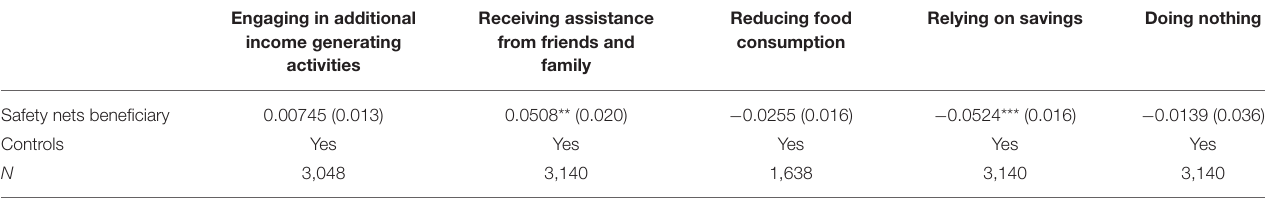
TABLE 7 | Southern region regression results on safety nets.